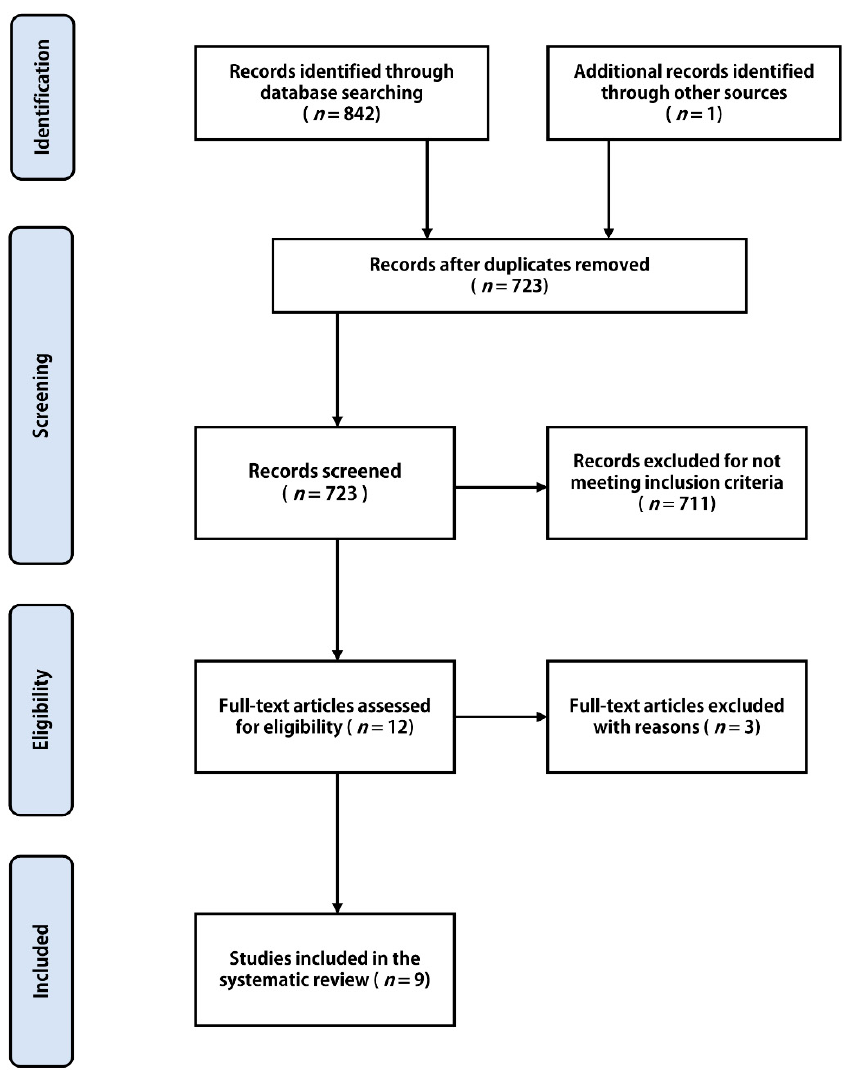
Figure 1. PRISMA flow chart of study identification and inclusion into the systematic review.